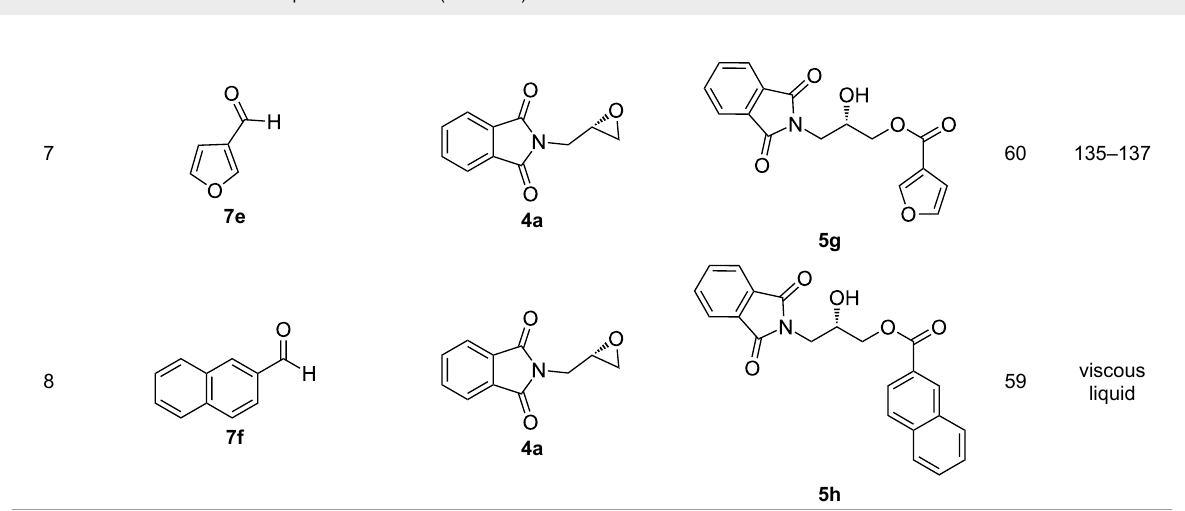
Table 2: Oxidative esterification of epoxies with NHC. a